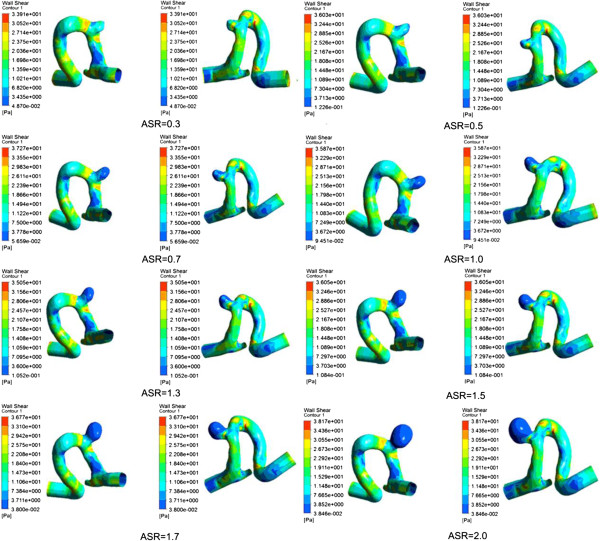
The distribution of WSS at peak systole. The image described the location of the aneurysm sac. And the remaining images showed WSS distribution of the scaled models including the original aneurysm. The WSS distributions showed that there were significant differences between different aneurysm models.